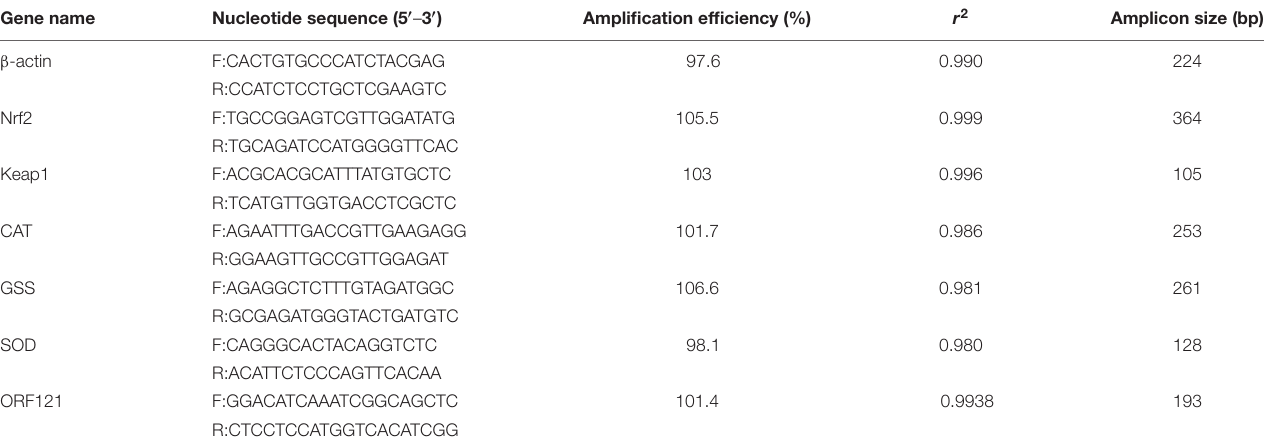
TABLE 1 | Verification primers for oxidative stress-related